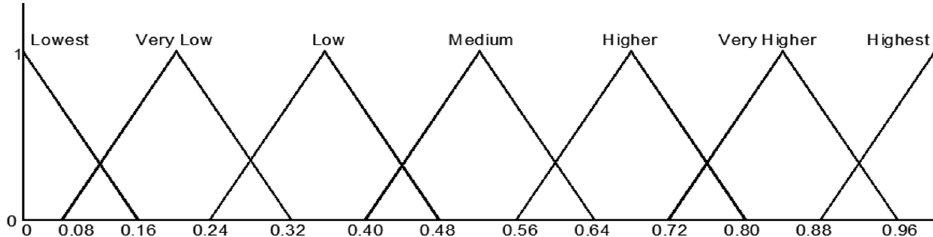
Figure 7. Membership functions for multi-response output .